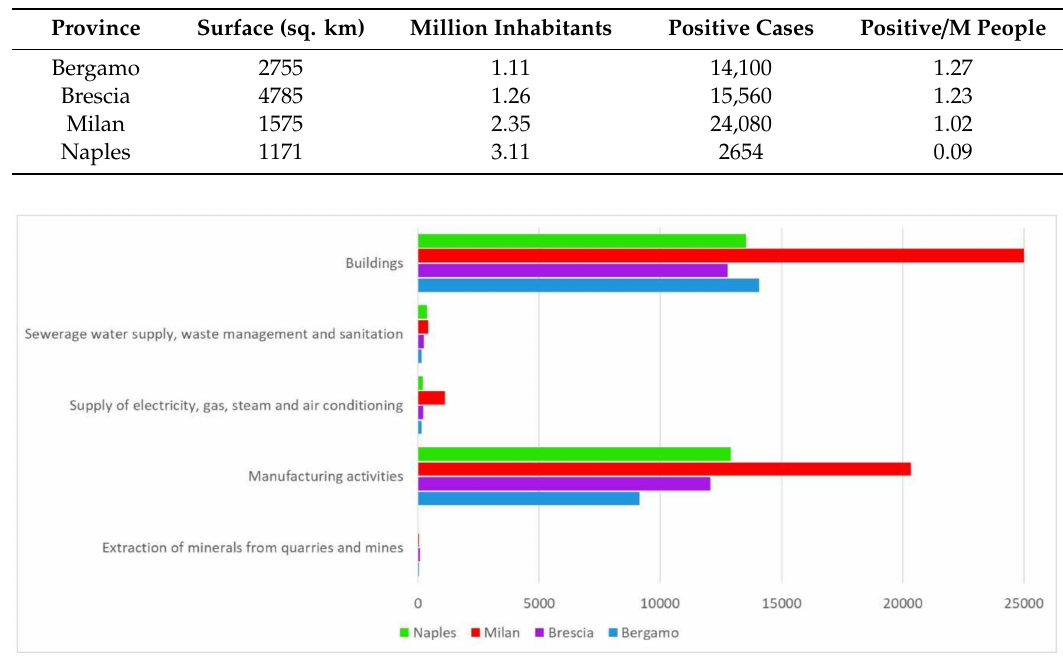
Figure 6. Presence of secondary sector in the four examined